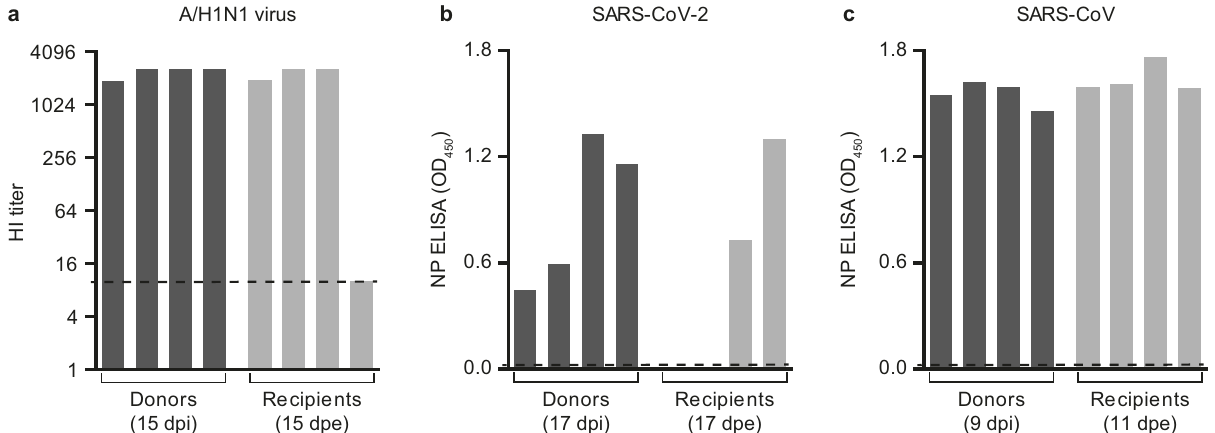
Fig. 4 Antibody responses in donor and recipient ferrets. Sera were collected from donor and recipient ferrets on the indicated days. Antibody responses against A/H1N1 virus ( a ) were measured by hemagglutination inhibition (HI) assay, whereas responses against SARS-CoV-2 ( b ) and SARS-CoV ( c ) were assessed using a nucleoprotein (NP) ELISA. Dotted lines indicate the detection limit of each assay. OD: Optic